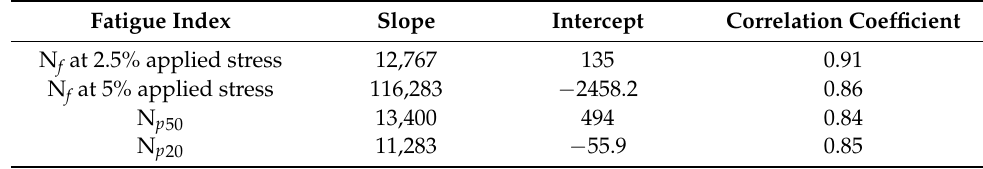
Table 16. Standard deviation of high-temperature index.